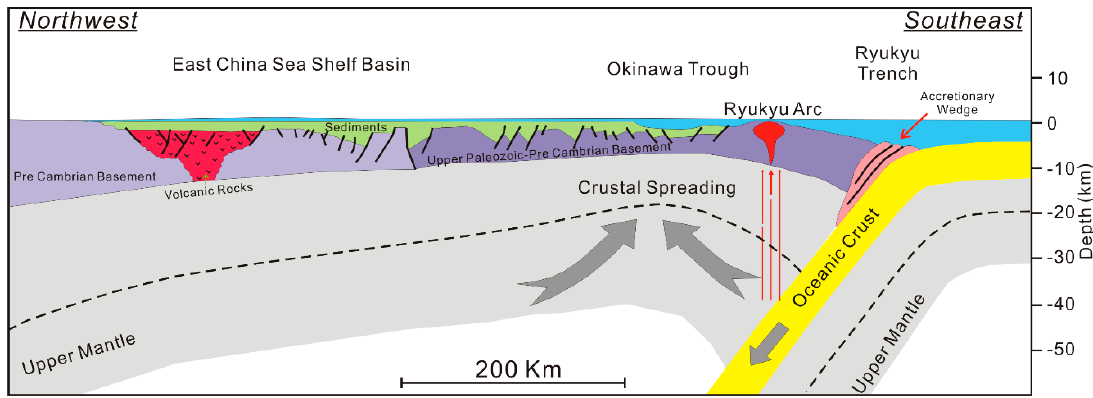
Figure 2. Schematic tectonic cross-section across the East China Sea basins. The East China Sea Shelf Basin and the western part of Okinawa Trough are modified from Reference [1], while the eastern part of the Okinawa Trough and Ryukyu Trench is a schematic. The thicknesses indicated here are approximate. Four main tectono-stratigraphic cycles are distinguished in the evolution of the basins [1,24,34–38]. It is important to note that these cycles are not time-equivalent throughout the area (Figure